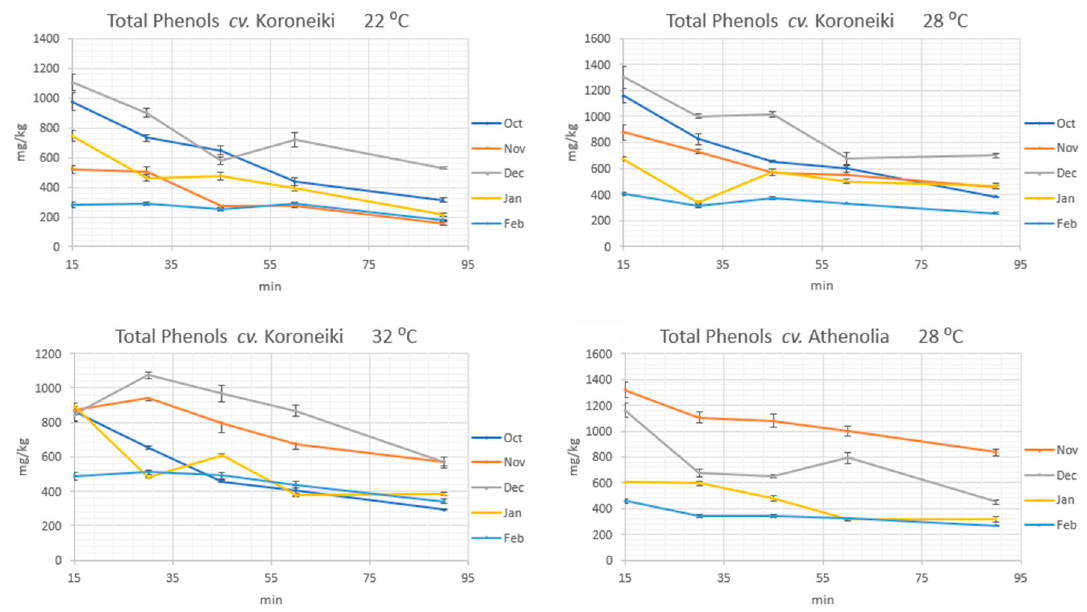
Figure 2. The total phenolic concentration of cv Koroneiki at five different ripening degrees during malaxation time at three different temperatures and for cv Athenolia at 28 °C, at four different ripening degrees.